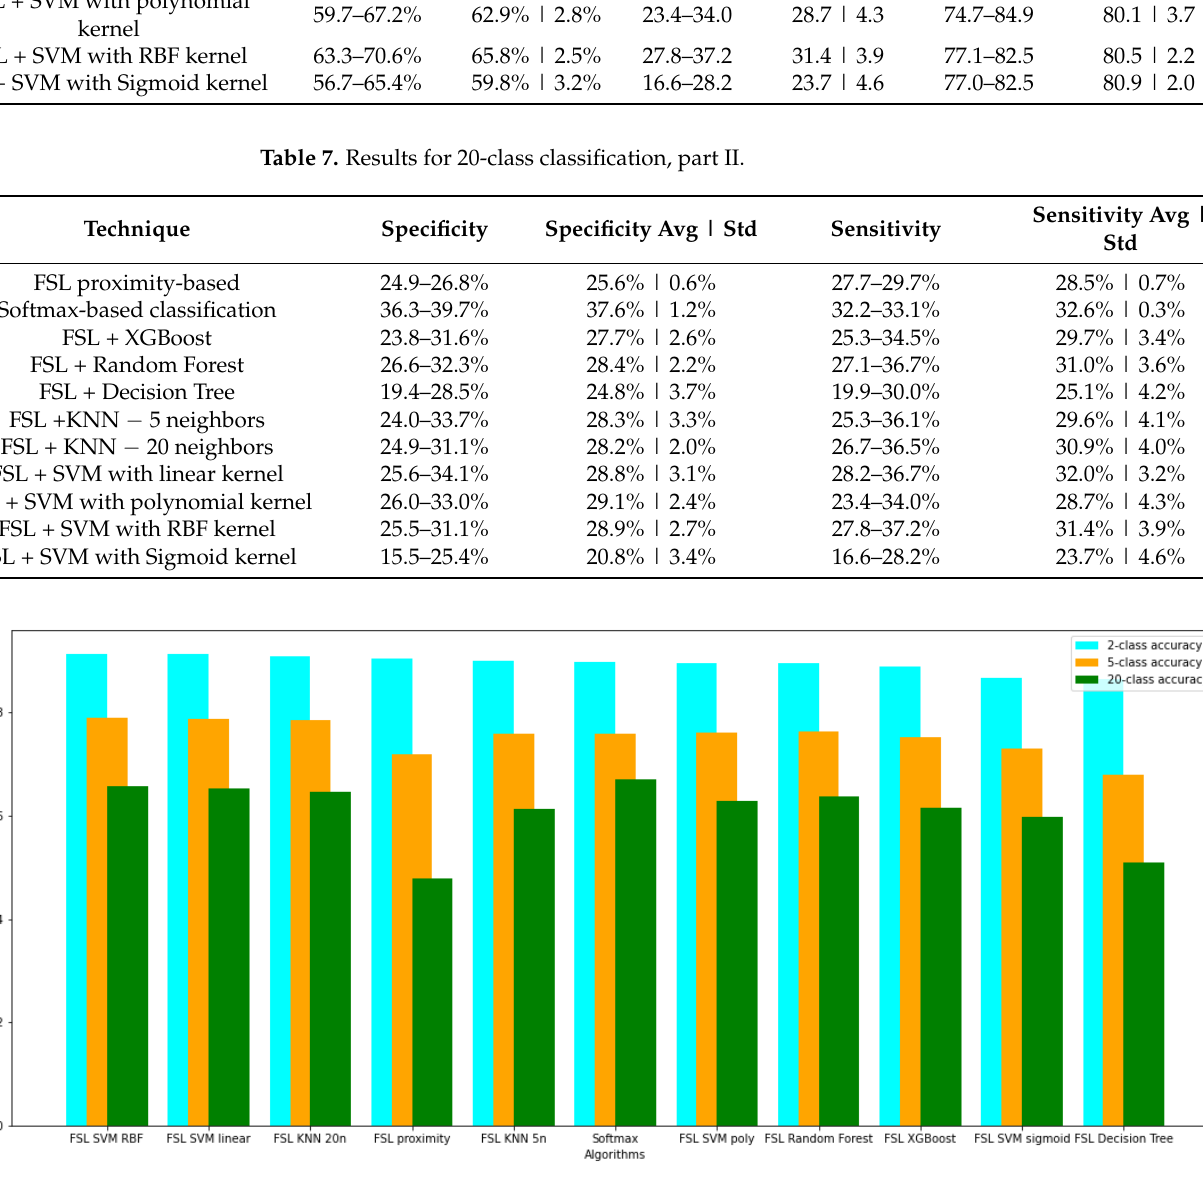
Figure 6. Comparison of average accuracy of evaluated models on 2, 5, and 20 classes